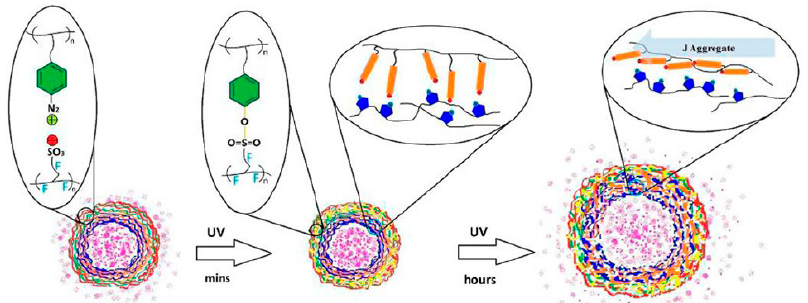
Figure 10. Photoresponses of dual-functional LbL microcapsules composed of (PAZO/PDDA) + (diazo resin (DAR)/Nafion) shells. Reprinted with permission from Ref. [87]. Copyright 2013 American Chemical Society.